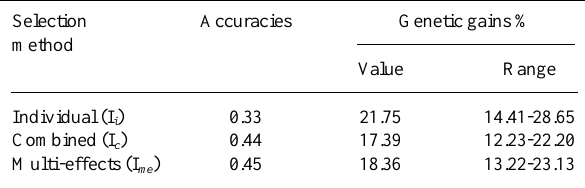
Table V - Genetic gains for accuracies and genetic gain ranges for rubber production for three different methods of selection in three-year-old rubber tree progenies, in Jaú.